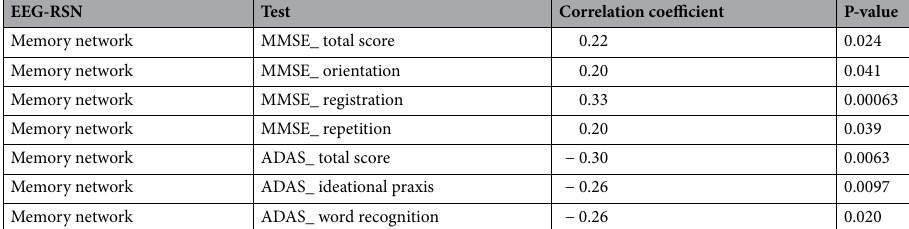
Table 3. Spearman’s rank correlation coefficients of EEG resting-state network (RSN) activities with cognitive function test scores in AD and ADMCI patients. AD, Alzheimer’s disease; ADMCI, Mild cognitive impairment due to AD; MMSE, Mini-Mental State Examination; ADAS, Alzheimer’s Disease Assessment Scale-cognitive component-Japanese version. The correlation of EEG-RSN activities with cognitive function test scores was assessed by Spearman’s rank correlation analysis (uncorrected for multiple comparison).